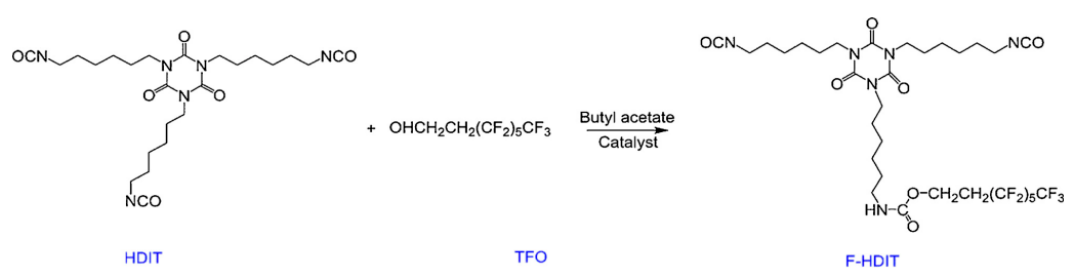
Figure 1. Structures of fluorine unit for preparing polyurethane (PU) was endowed with low surface free energy and great wetting ability [15].